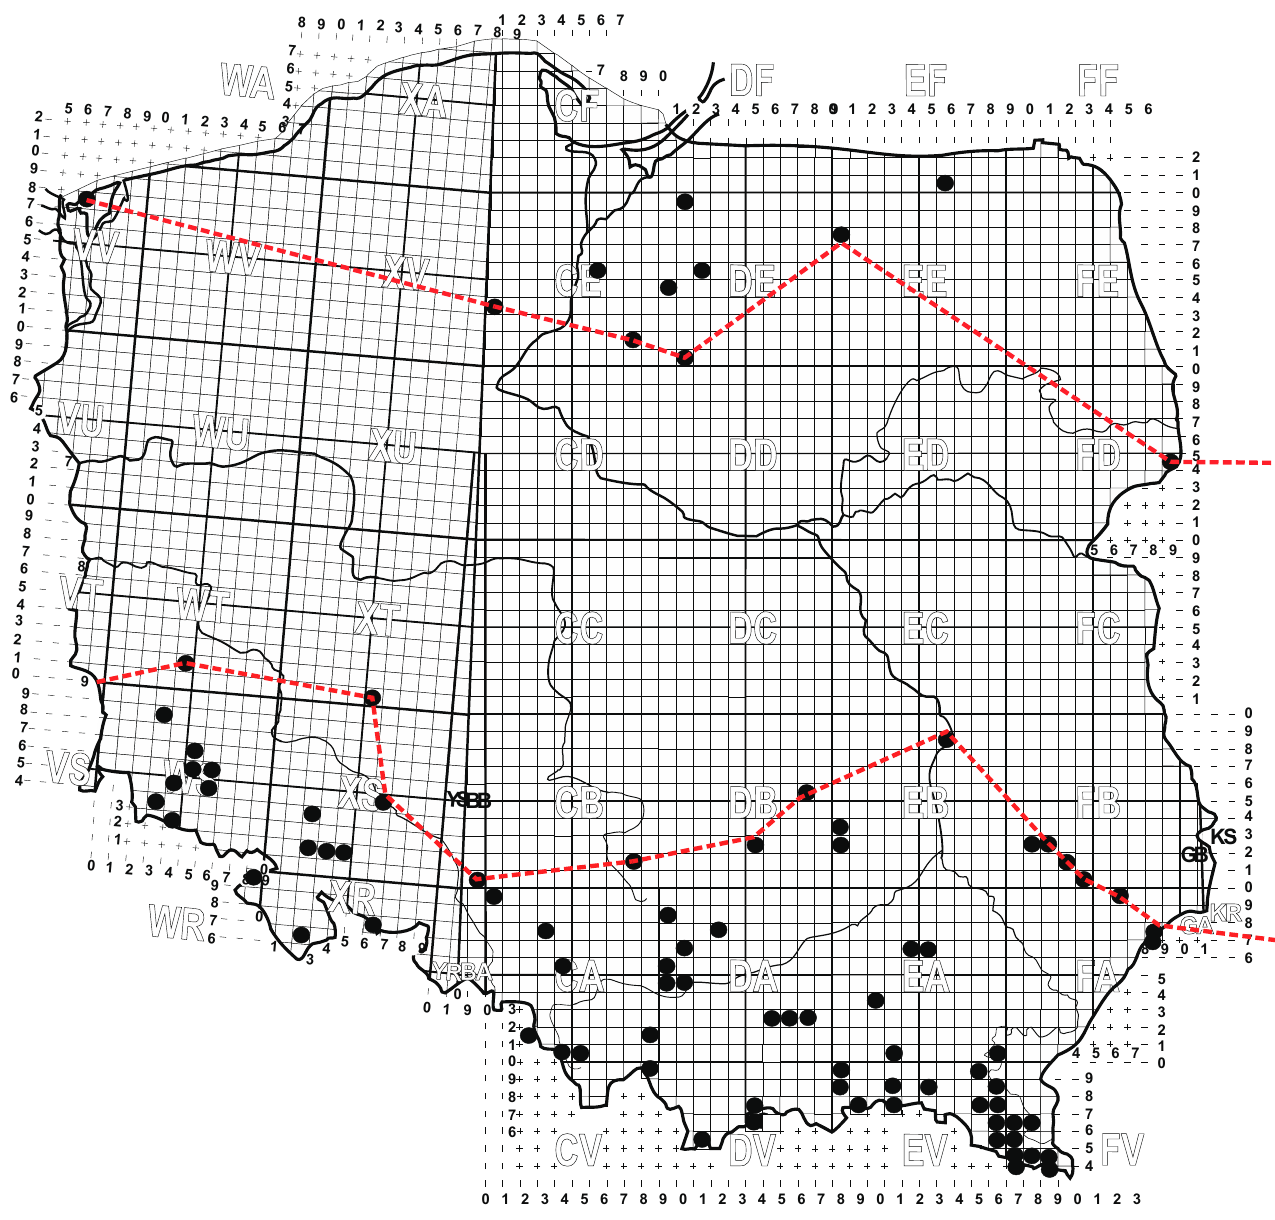
Figure 6. Geographical distribution of Neodiscopoma splendida ; the red dashed lines mark the boundaries of the southern and northern populations.